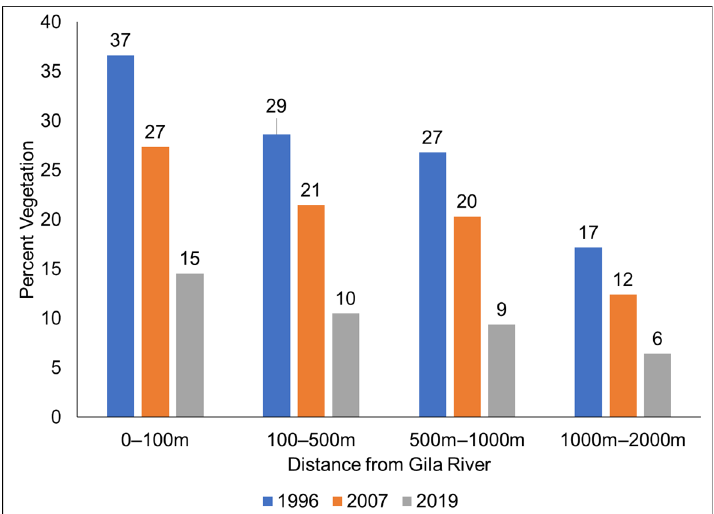
Figure 5. Amount of vegetation in relation to distance from Gila River 1996, 2007 and 2019. We created bu ff ers at 0–100 m, 100 m–500 m, 500 m–1000 m, and 1000 m–2000 m from the Gila River in our study area. We then calculated the percentage of vegetation cover in each buffer for 1996, 2007, and 2019 using the classified rasters.